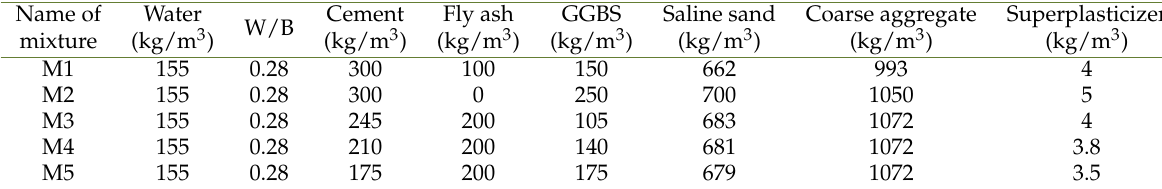
Table 2. Mix proportions of different